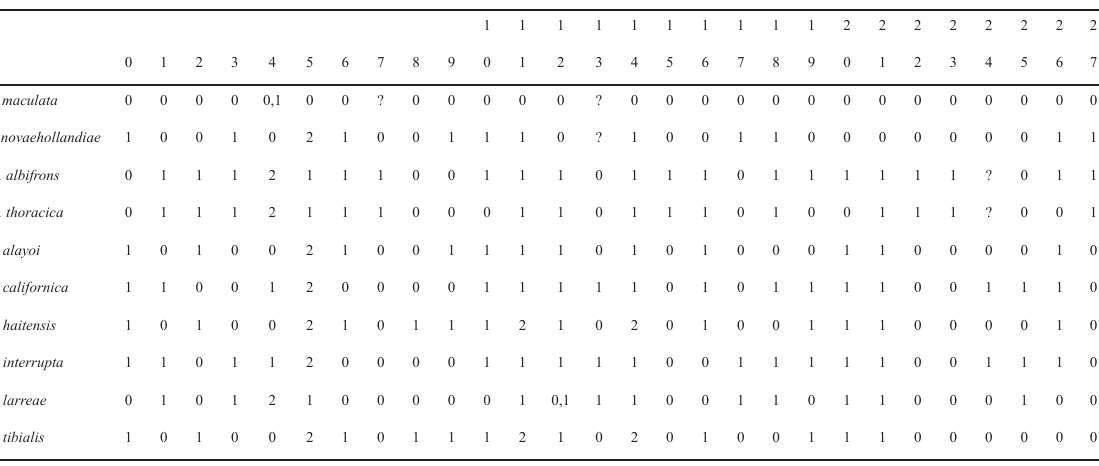
Table 1. Matrix of morphological characters used in phylogenetic analysis in TNT. Numbers in column headers indicate character identifiers (see Supp. file 2 for the corresponding descriptions). Character states separated by a comma indicate polymorphisms. Unknown character states and states that were not scored for certain taxa because they are inapplicable are denoted by question